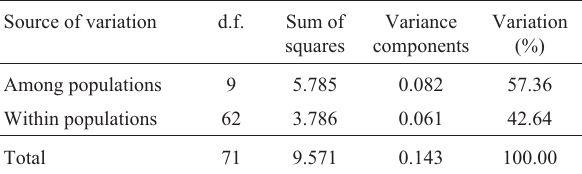
Table 4 - Analysis of molecular variance (AMOVA) among the locations where samples of A. robusta were collected. Source of